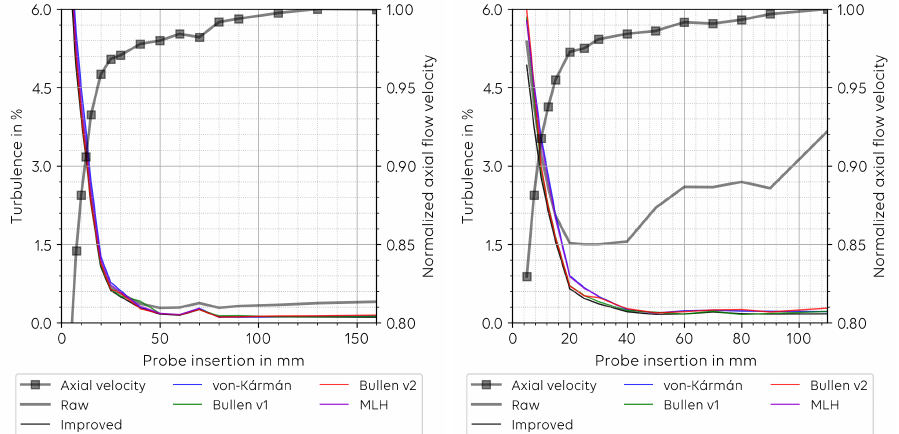
Figure 13. Turbulence intensity of the longitudinal velocity component. Results obtained for all estimator techniques, several probe radial positions, and for two rotor speeds. ( Left ): η 1 ≈ 3800 RPM. ( Right ): η 2 ≈ 6840 RPM.